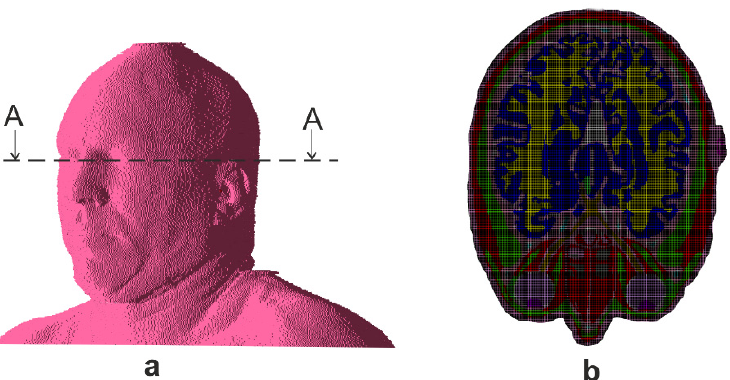
Figure 4. Location of Power density virtual sensor: ( a ) with reference to the head, ( b ) FDTD model cross-section in A-A plane at the sensor level.